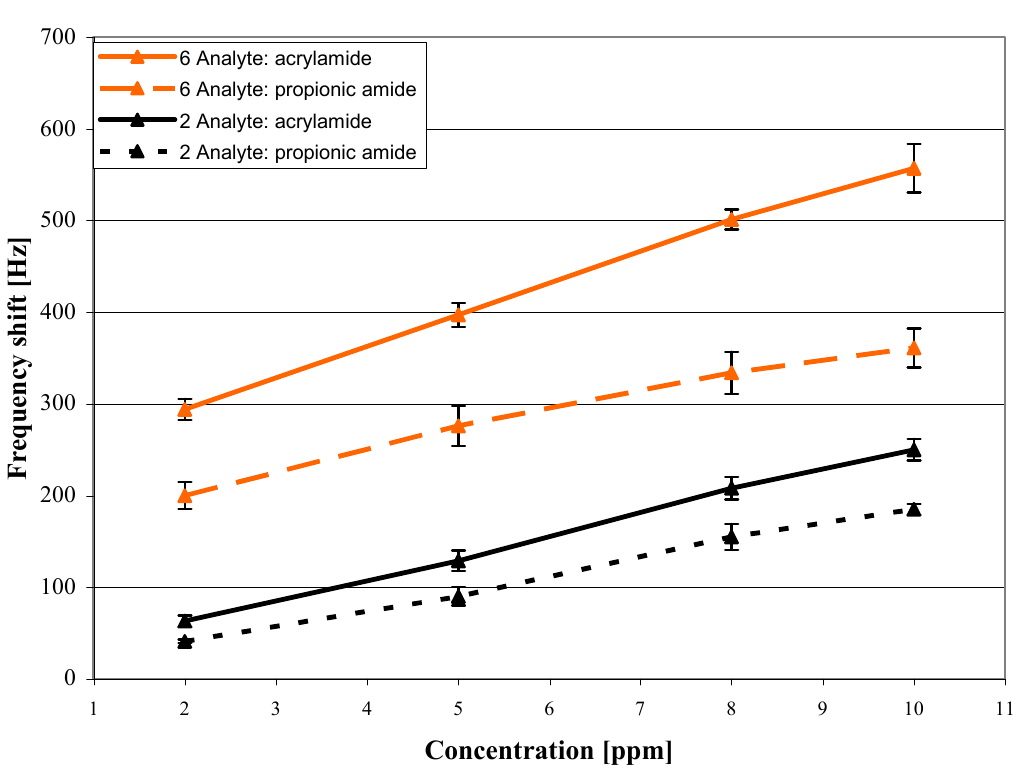
Figure 7. Characteristic responses of the analytes acrylamide and